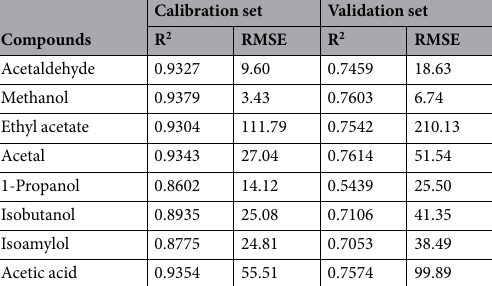
Table 4. Prediction results of volatile compounds based on PLSR. R 2 : correlation coefficient, RMSE: root mean square error. The larger R 2 and the lower RMSE are, the better the prediction model